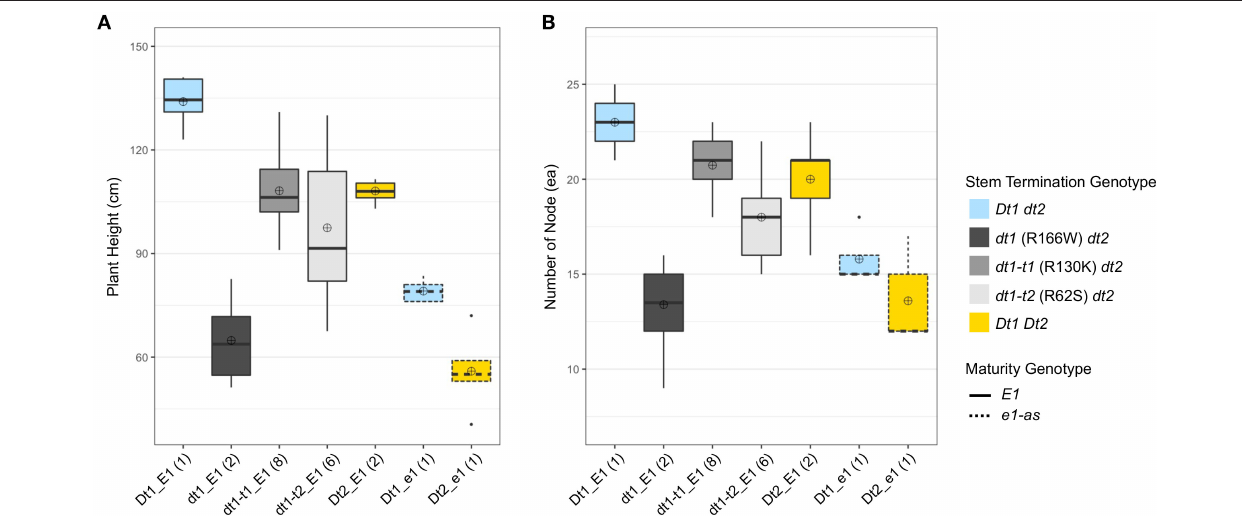
FIGURE 2 | Boxplots of plant height and number of nodes depending on genotype categories examined in 2019 at Athens, GA (19GA). A total of 21 soybean lines with each allele combination for genes related to stem termination type and maturity were evaluated. The colors of each box were designated based on the allele status of the two genes conferring stem termination type, Dt1 and Dt2 . The outlines of each box were designated based on the allele status of the E1 maturity gene. Sixteen soybean lines under three genotype categories, dt1-t1_E1, dt1-t2_E1, and Dt2_E1, were experimental lines from KB17-16 (F 3 : 4 ), KB17-17 (F 3 : 4 ), and either KB17-7 or KB17-8 RIL populations (F 4 : 5 ), respectively. The other five soybean lines were control cultivars. Each genotype category has an unequal number of soybean lines, and the number of lines was written in parentheses beside each genotype category. The plant height and the number of nodes were measured from five individual plants per line. ⊕ in each box represents mean values of each genotype category. (A) Displays the distribution of final plant height at maturity in cm. (B) Shows the distribution of number of nodes counted on the main stem at